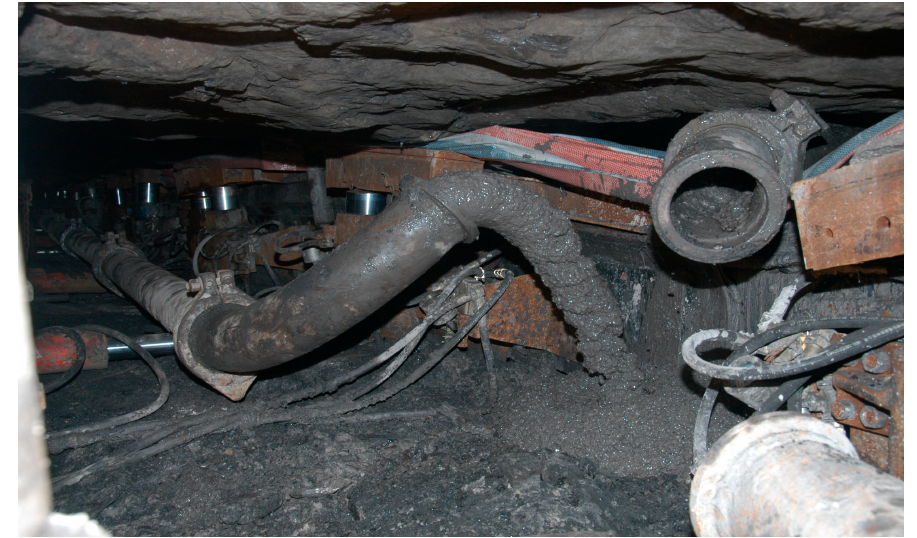
Figure 10. The connection and disconnection of the heavy filling pipeline.